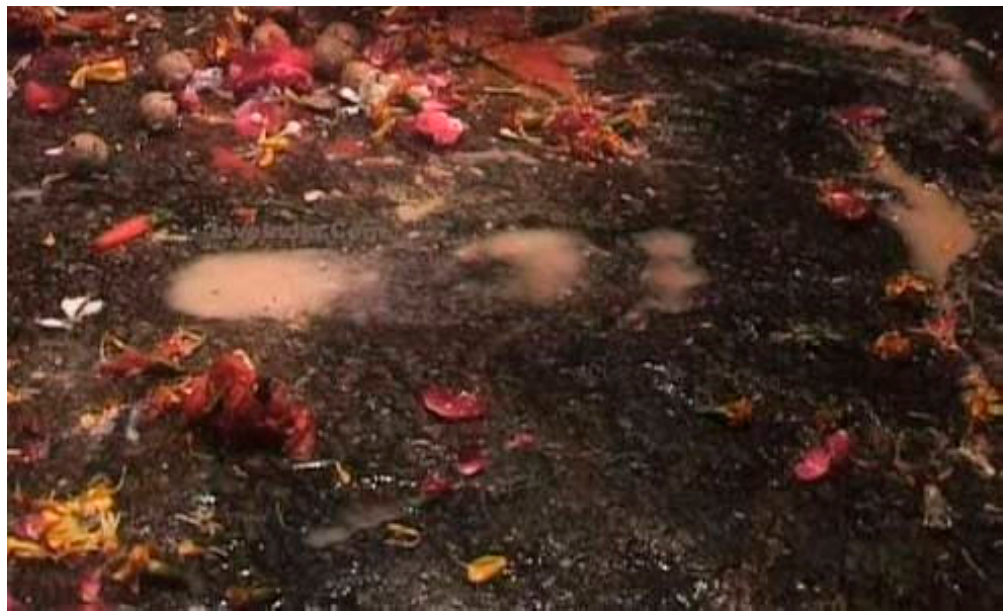
Figure 1. Gay ā —the footprint with traces of milk, petals and pi ṇḍ as (Albertina Nugteren). Figure 1. Gay¯a—the footprint with traces of milk, petals and pin. d. as (Albertina